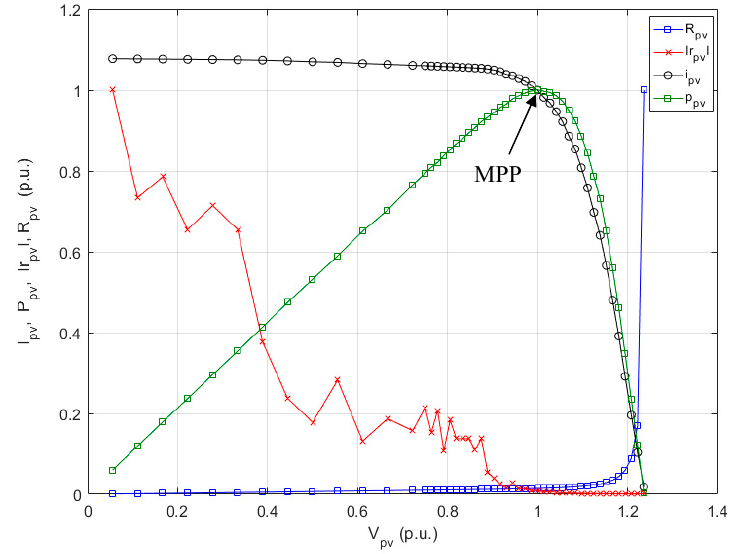
Figure 17. The characteristic per-unit curves of the constructed PV source at excitement current of I cs = 3.14 A.